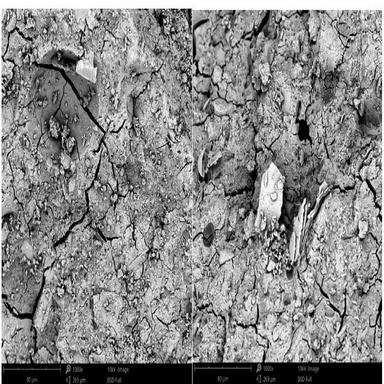
SEM images of A1 (left) and C5 (right) after 7 days of curing.